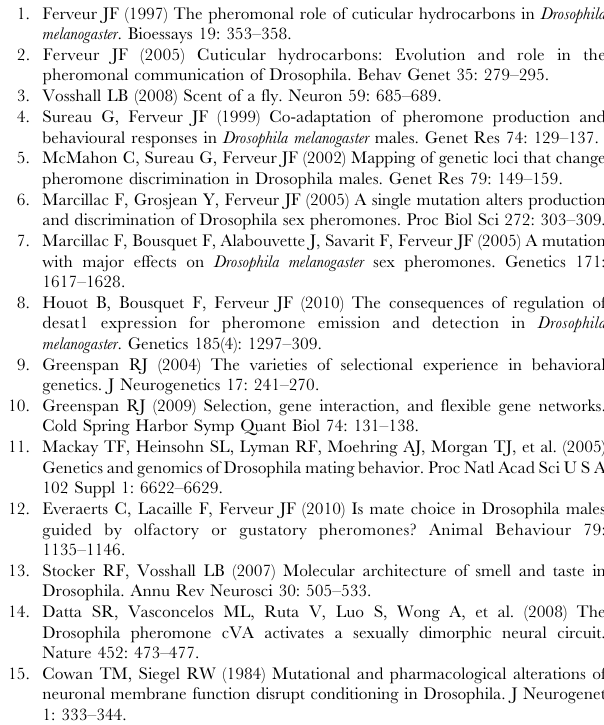
Figure S1 q-PCR in RNAi strains. RNA levels were measured in the heads of control (empty bars) and Elav155- Gal4 . UAS-RNAi males (filled bars). When targeted by Elav155- Gal4 , the two RNAi transgenes ( UAS-qtcIR , top and UAS-Sh2IR , bottom) significantly (*: p , 0.05) decreased the expression of qtc (1/2.65) and Sh (1/2.00), respectively. These data were obtained with 9 biological replicates. Table S1 Levels of the principal sex pheromones in manipulated males. Data shown corrrespond to the mean ( 6 sem; in ng) for the principal cuticular hydrocarbons in males of various strains. These compounds are: 7-tricosene (7-T), n- tricosane (23Lin), methyl-tetracosane (25Br), 7-pentacosene (7-P), n-pentacosane (25Lin), methyl-hexacosane (27Br), n-heptacosane (27Lin), methyl-octacosane (29Br). We also show the sum of all CHs ( S CHs). From top to bottom, strains correspond to the wild- type (Dijon) and the mutant desat1 strains, to the high and low selected lines in the desat1 and in the wild-type backgrounds, to the qtc, Sh1, Sh2 mutations in the wild-type and in the desat1 backgrounds. N $ 15.